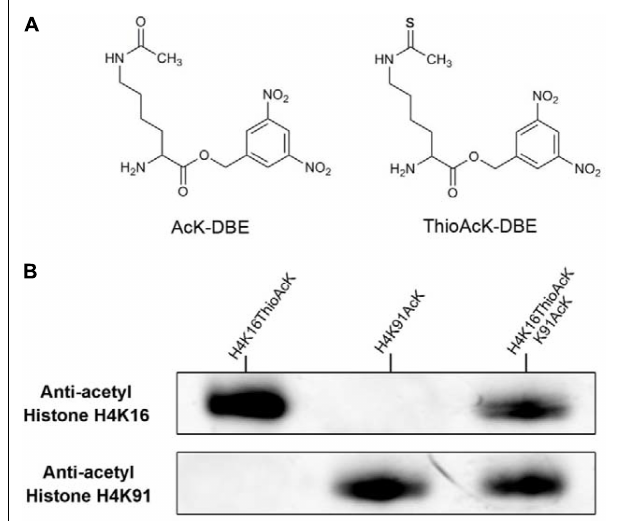
FIGURE 1 | (A) Structure of acetyl-lysine 3,5-dinitrobenzyl ester (AcK-DBE) and thioacetyl-lysine 3,5-dinitrobenzyl ester (ThioAcK-DBE). (B) Western Blots of single or dual ncAAs (AcK, ThioAcK) residues into H4 variants (H4K16_ThioAck/H4K91_AcK) with site-specific anti-acetyl histone antibodies (Abcam, ab109463, ab4627). 10 µ L of the corresponding PURE reaction solution was loaded into each lane.